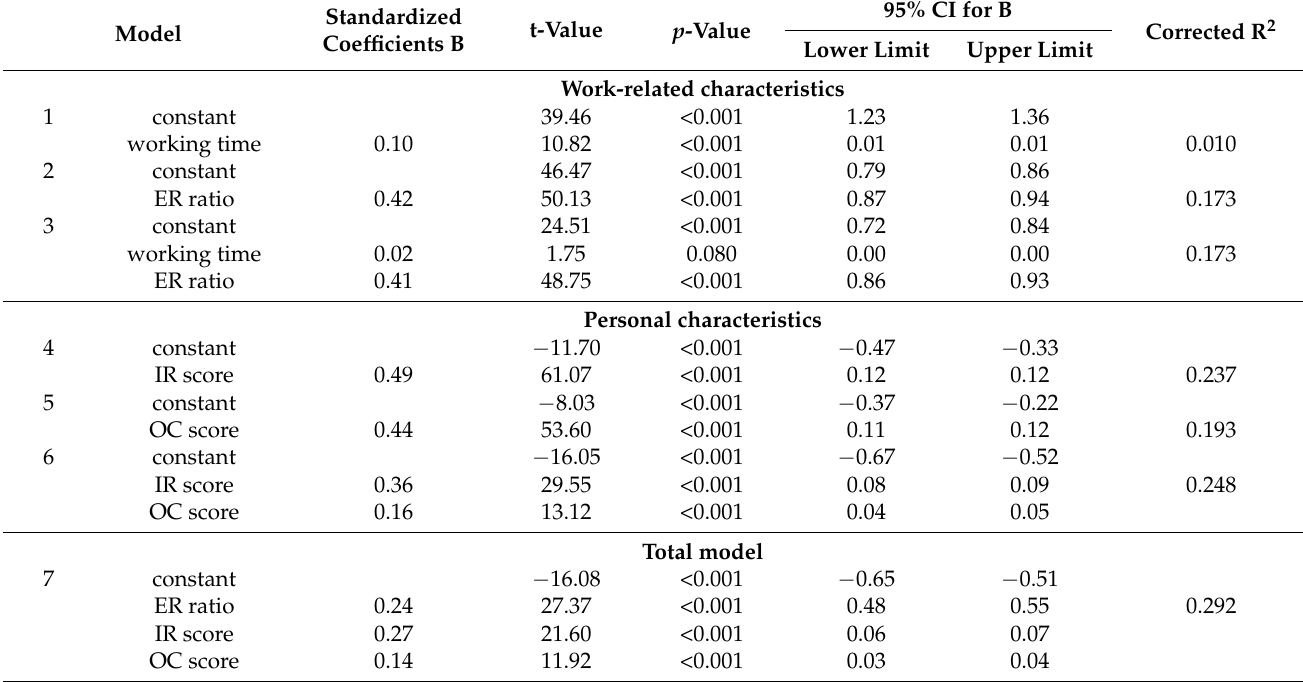
Table 7. Regression models of work-related and personal characteristics with burnout risk in teachers (n =